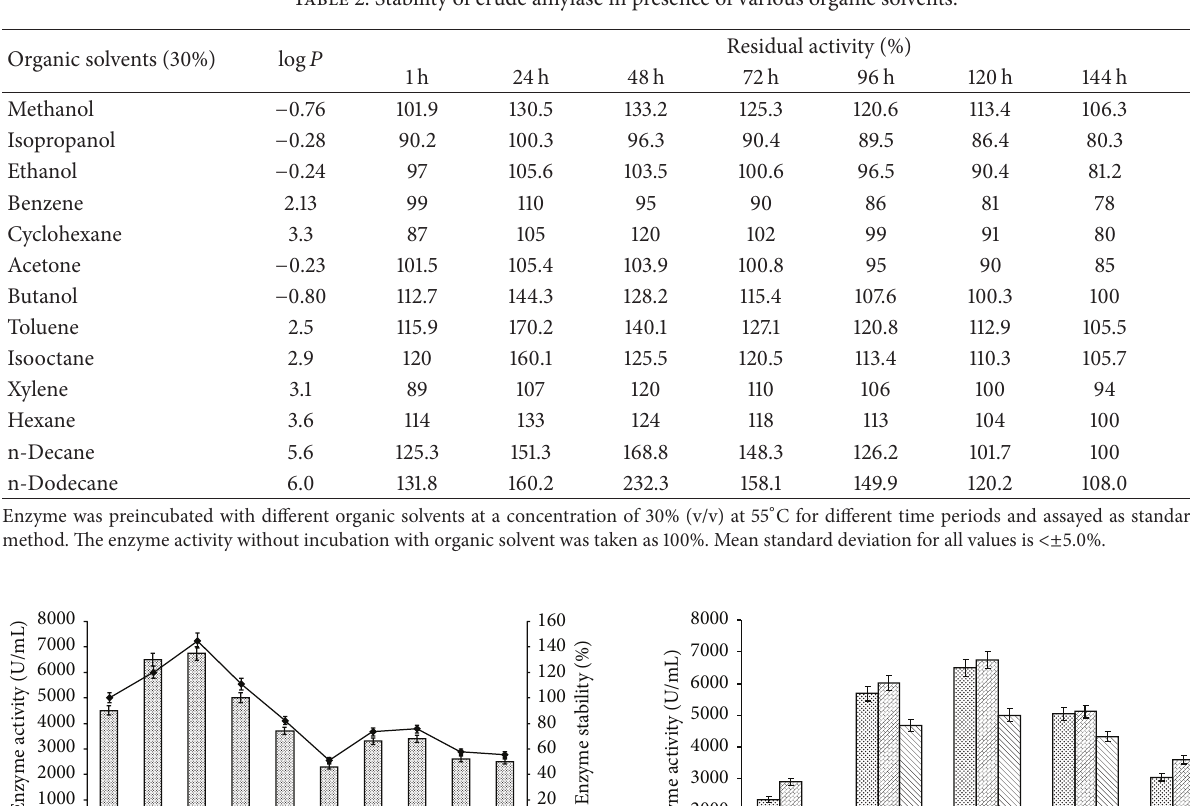
Table 2: Stability of crude amylase in presence of various organic solvents.